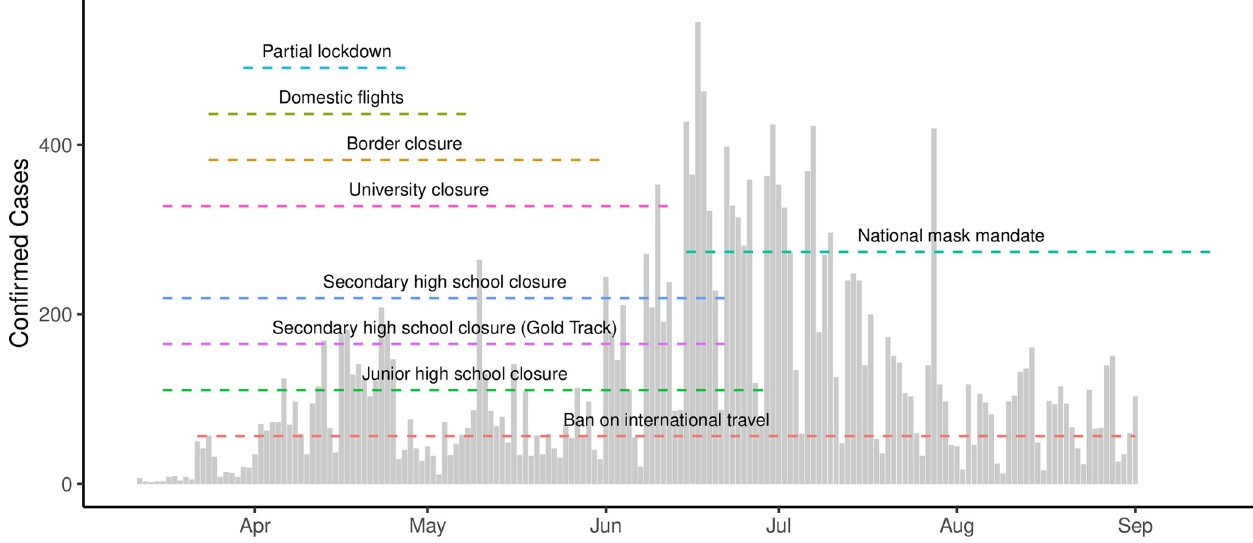
Fig 1. Confirmed COVID-19 cases and non-pharmaceutical interventions. The total number of confirmed cases of COVID-19 in districts included in this study. The timeline of different non-pharmaceutical interventions are indicated with dashed lines.